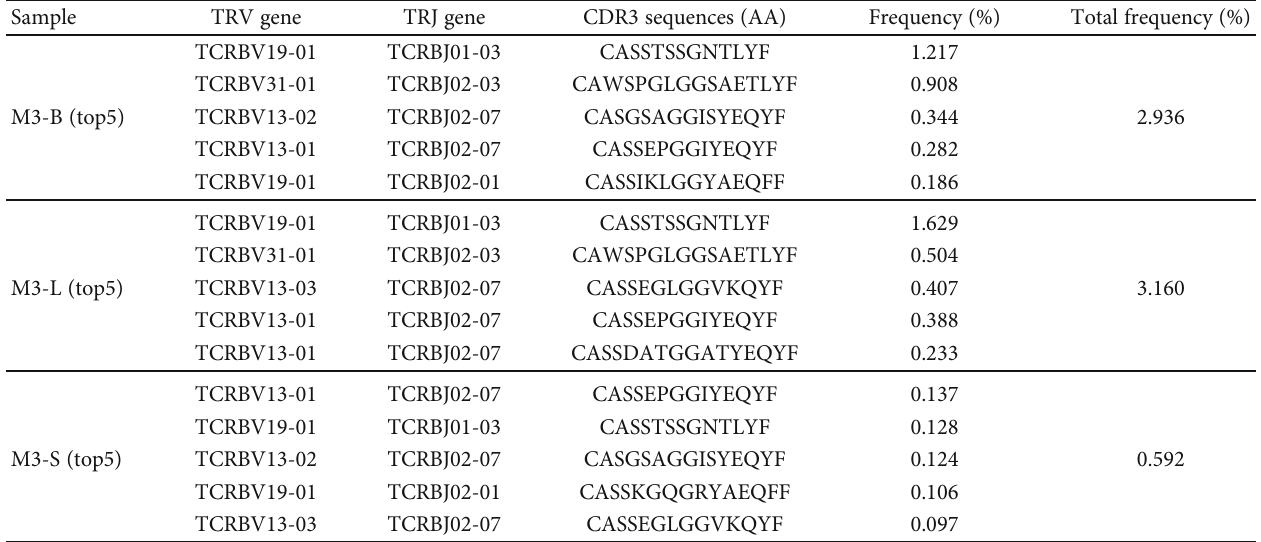
Table 3: Analysis of composition and characteristics of frequency for the top fi ve sequences and the usage of TRBV and TRBJ gene, CDR3 AA of CD4 + CD25 + T cells TCR β CDR3 repertoires in breast tumor tissues, lung metastatic tissues, and spleens from 4T1 tumor-bearing BALB/c mouse 3.